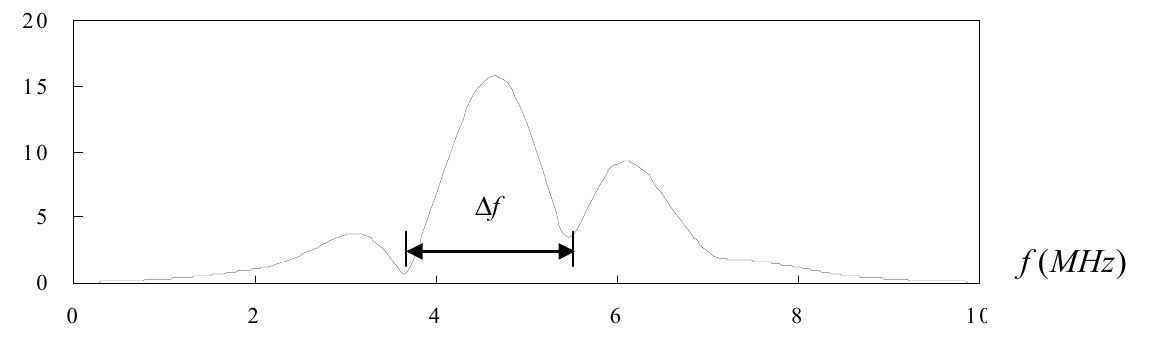
Figure 8. Fourier transform of two pulses with time